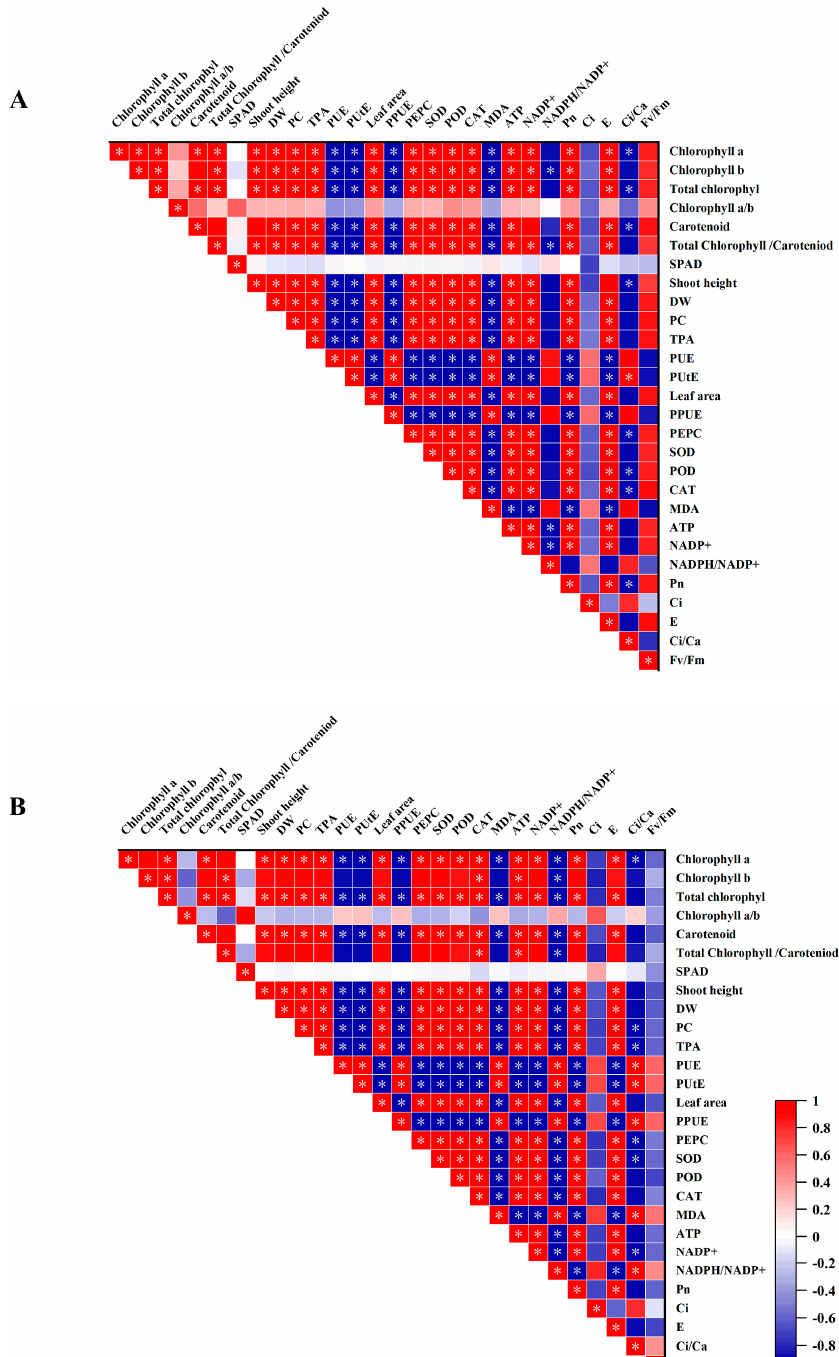
Figure 8. Correlation analysis among measurement indicators in the ( A ) LP-sensitive genotypes and ( B ) LP-tolerant genotypes. Asterisk shows significant differences at p < 0.05. Chl a,b (Chl a,b), net photosynthetic rate (Pn), intercellular CO 2 (Ci), the ratio of intercellular-ambient-CO 2 concentrations (Ci/Ca), and transpiration rate (E), the maximal quantum efficiency of PSII photochemistry (Fv/Fm), P concentrations (PC), P accumulation (TPA), P-use efficiency (PUE), P-uptake efficiency (PUtE), photosynthetic-P-utilization efficiency (PPUE), SPAD (SPAD value), dry weight (DW), superoxide dismutase (SOD), peroxidase (POD), catalase (CAT), malondialdehyde content (MDA), phospho- enolpyruvate carboxylase (PEPC) adenosine triphosphate (ATP), nicotinamide adenine dinucleotide phosphate (NADP + ), and nicotinamide adenine dinucleotide phosphate (NADP). *: p <